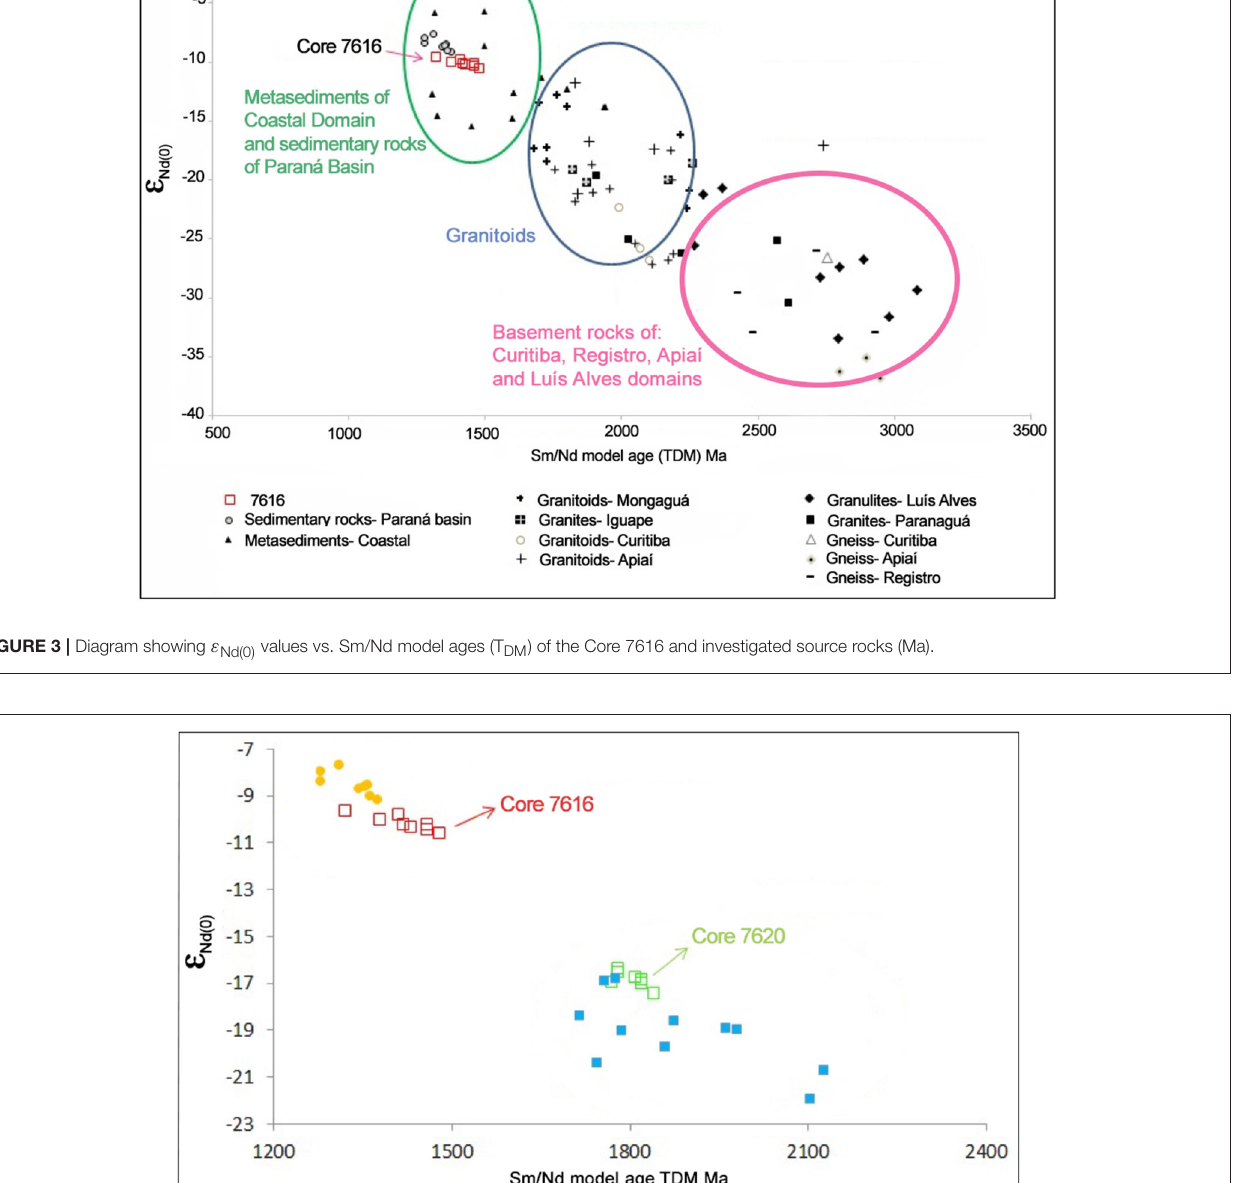
The data fit the condition for a suitable PCA, showing normal distribution and correlation between Nd parameters